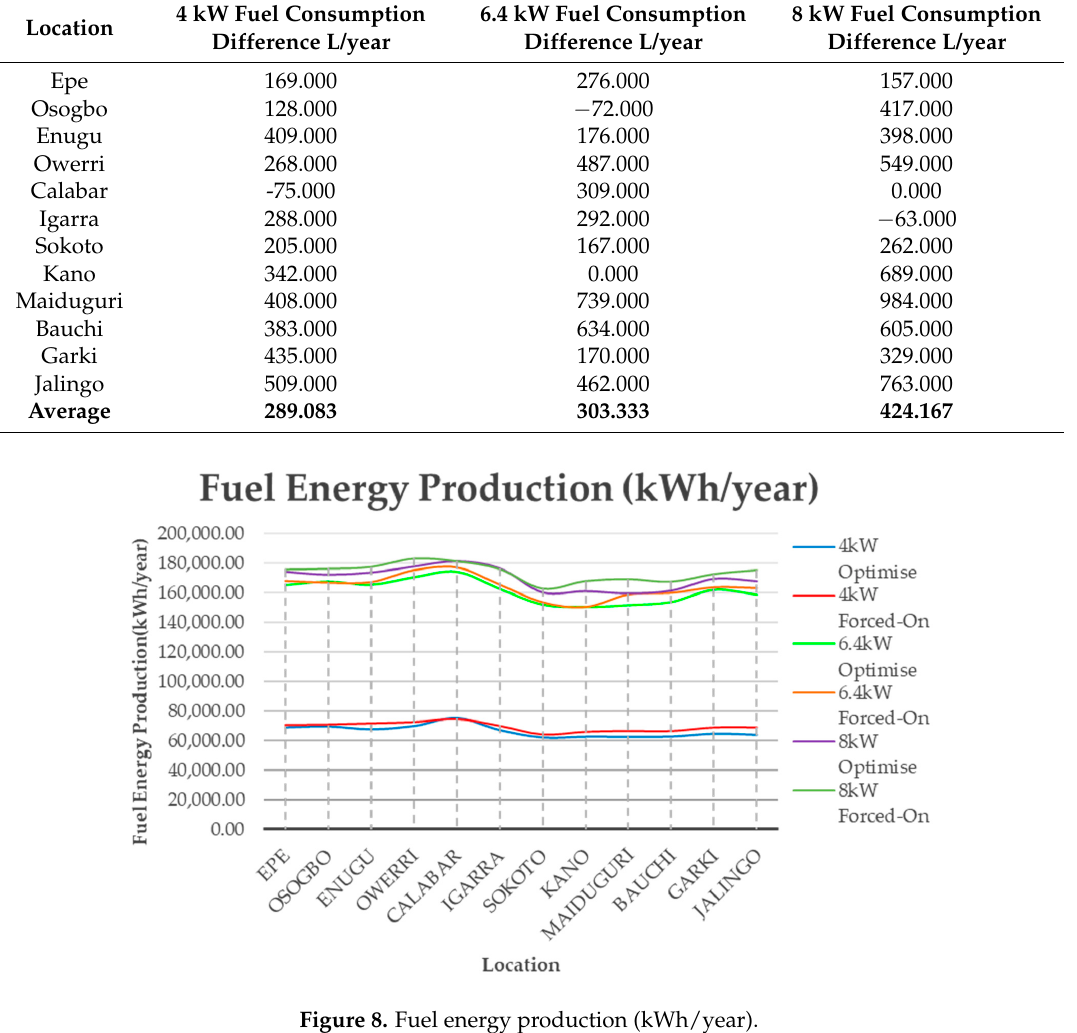
Figure 8. Fuel energy production (kWh/year).